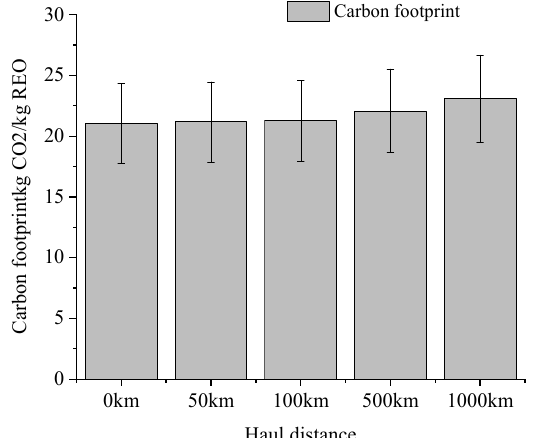
Figure 4. Effect of material transport distance on carbon footprint of ionic rare earth development.